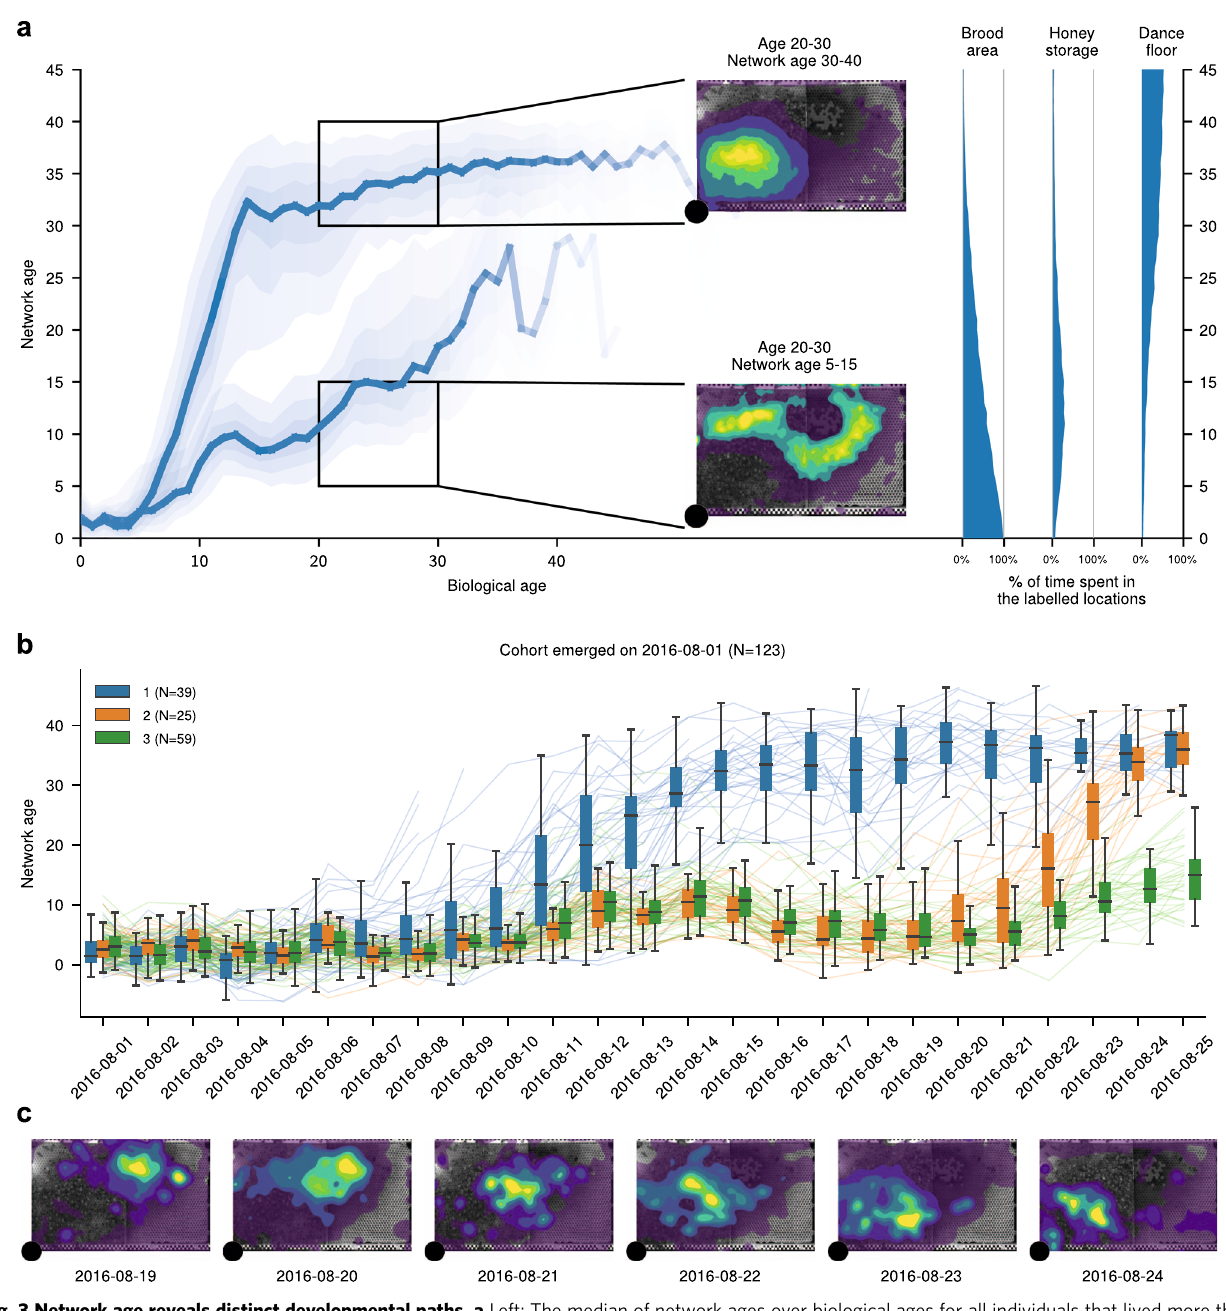
Fig. 3 Network age reveals distinct developmental paths. a Left: The median of network ages over biological ages for all individuals that lived more than 11 days split by a threshold on the age of 11 ( T = 23.07, calculated using Otsu ’ s method 84 .The upper line contains all bees that fall above this threshold ( N = 832), the lower contains all bees below that threshold ( N = 563). The shaded areas depict 20%, 40%, 60% data intervals. We observe a split in network age corresponding to different tasks: The upper heatmap (network age 30 – 40, biological age 20 – 30, 577 bees, 857,283 data points) corresponds to the dance fl oor, while the lower heatmap (network age 5 – 15, biological age 20 – 30, 381 bees, 742,622 data points) borders between the dance fl oor and brood nest. Right: The mean fraction of time a bee with a given network age spends on our annotated regions throughout a day. b Lines depict the network age of individual bees of a same-aged cohort with the colors indicating clusters of their network age over time. Boxes summarize bees belonging to each cluster for a given day (center line, median; box limits, upper and lower quartiles; whiskers, 1.5× interquartile range). c Heatmaps showing the spatial distribution of bees in the developmental cluster 2 (orange) from 19 August 2016 to 24 August 2016. The smooth transition in network age (orange in line plot, b ) from one mode to another corresponds to a smooth transition in spatial location (heatmaps, c ). The shaded areas depict density percentiles (brightest to darkest: 99%, 97.5%, 95%, 80%, 70%,